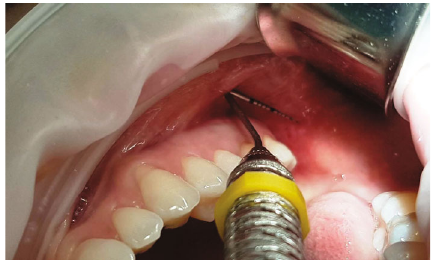
Figure 3: The incision location in donor site: vestibule fundus, at the distal caries of the second molar with a 30 mm distance from the vestibule and above the parotid duct.